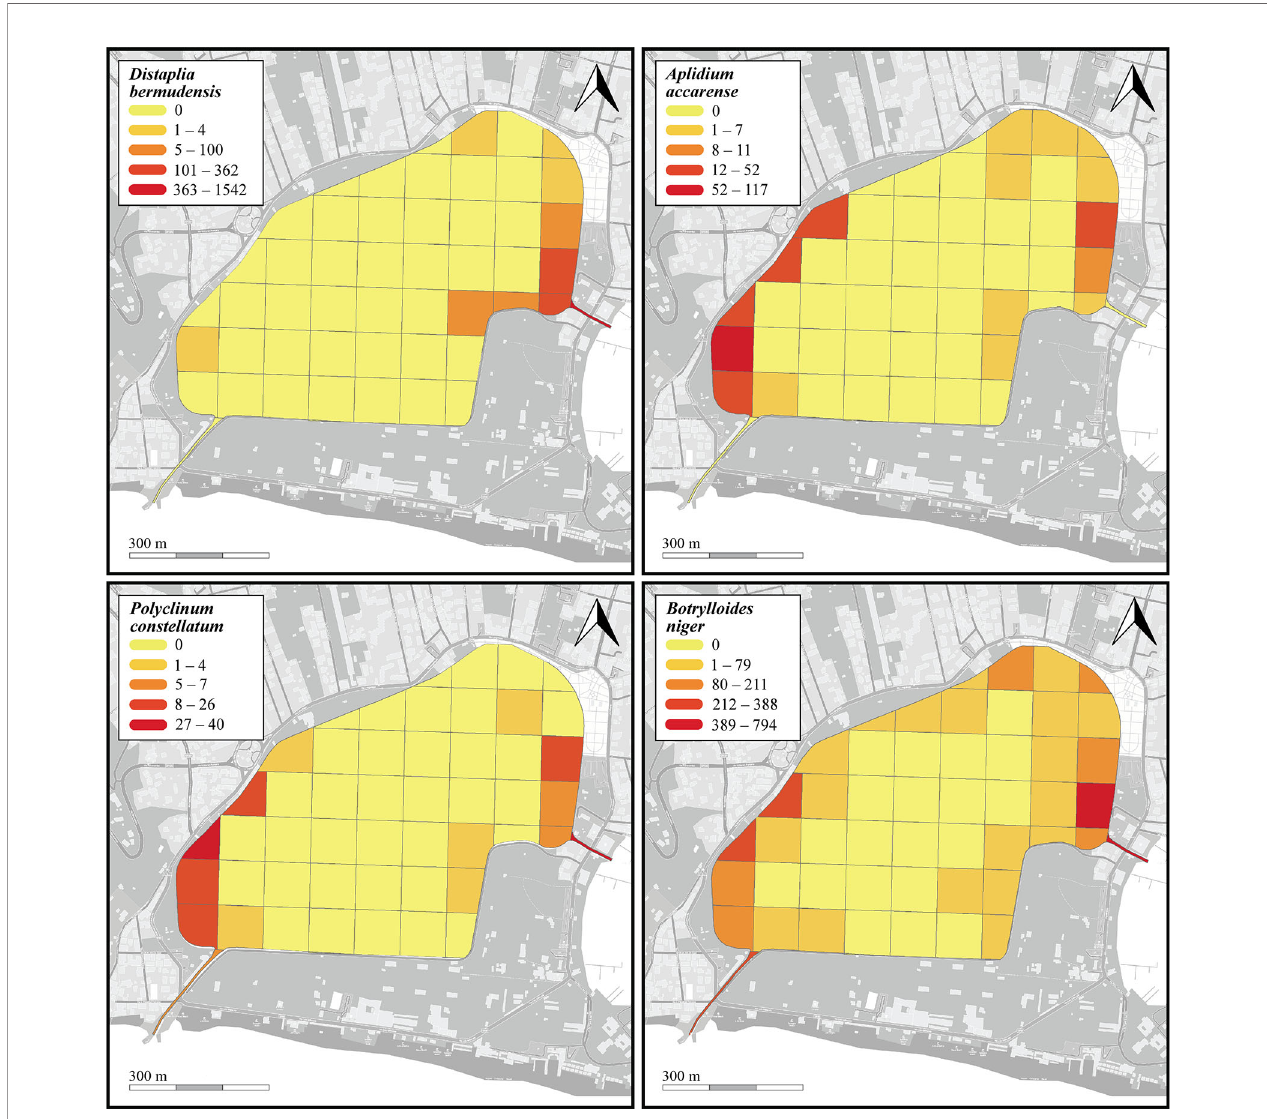
FIGURE 6 | Heatmaps showing abundance (counts per 100-m transect) of the four most common NIS ( Distaplia bermudensis , Aplidium accarense , Polyclinum constellatum , and Botrylloides niger ) found on the seabed of the Miseno Lake. For a detailed account of the sectors see Figure 1